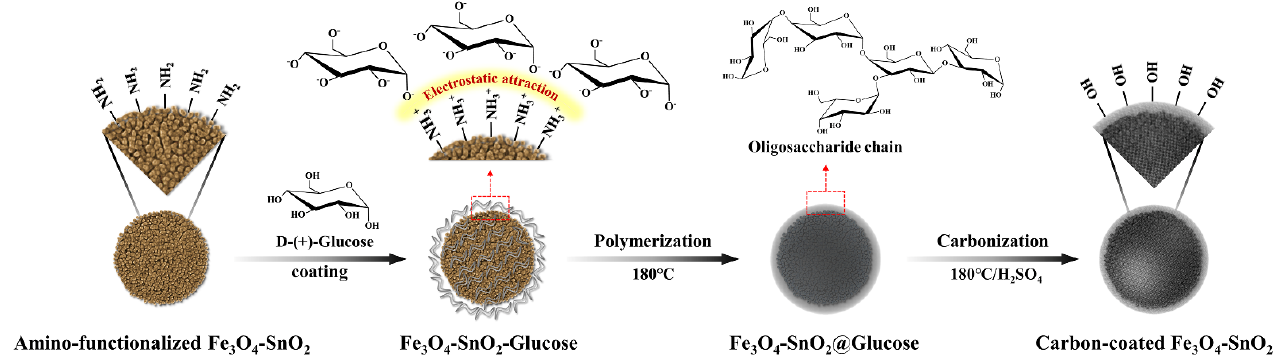
Figure 6. Schematic for the carbon-coating mechanism of amino-functionalized Fe 3 O 4 -SnO 2 nanoparticles through glucose and sulfuric acid.